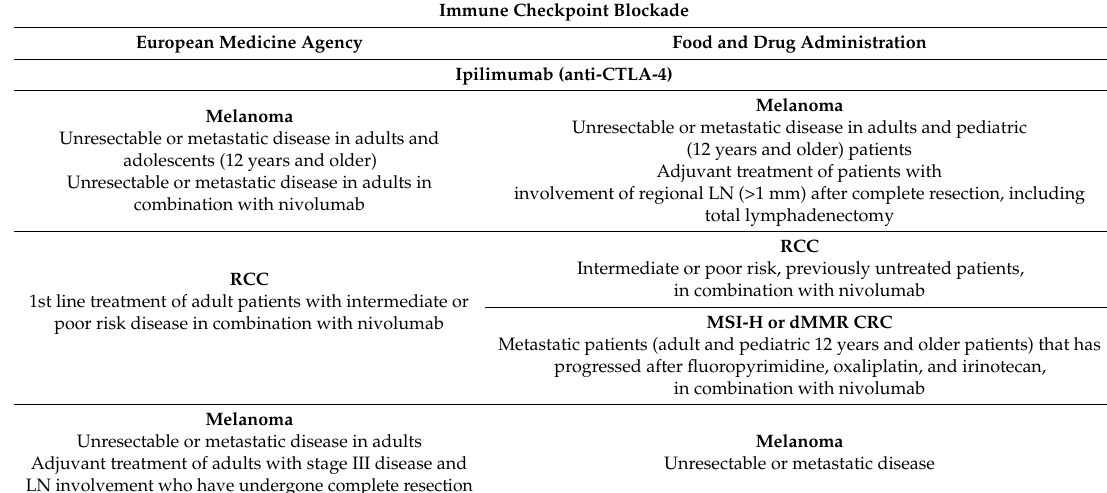
Table 1. Immune checkpoint blockade drugs approved in Europe and in the United States (last update: February